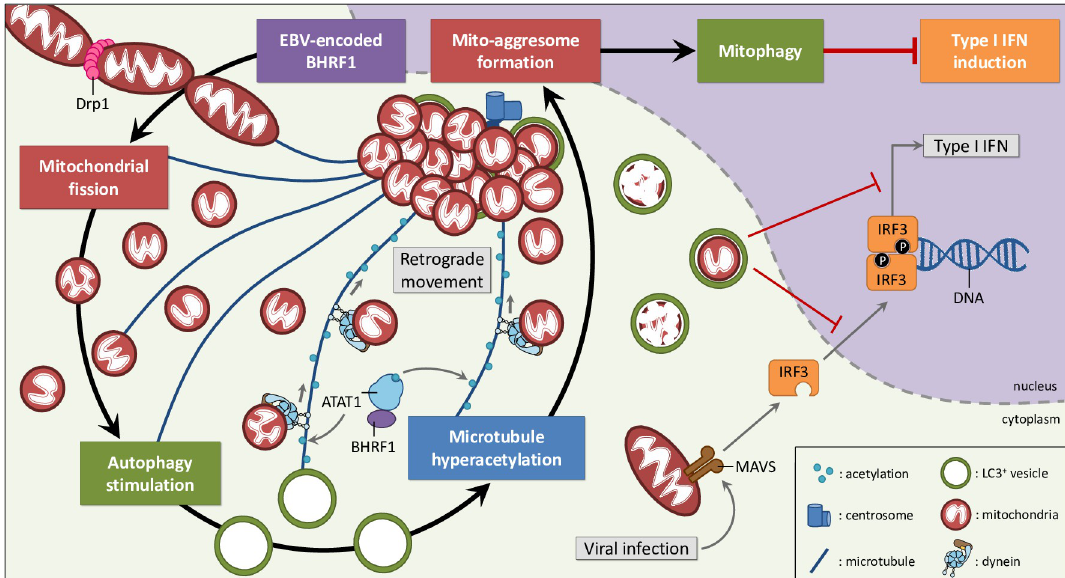
Fig 9. Working model. EBV encodes a Bcl-2 homolog that dampens type I IFN induction thanks to MT hyperacetylation. BHRF1 induces Drp1-mediated mitochondrial fission and subsequently autophagy. These cellular modifications lead to the mito-aggresome formation, and we demonstrated that the MT network and in particular its acetylation level are essential for this mitochondrial phenotype. Moreover, BHRF1 interacts with ATAT1 and induces MT hyperacetylation through ATAT1 activation. This hyperacetylation allows the retrograde transport of mitochondria in a dynein-dependent manner. Finally, sequestration and degradation of mitochondria block the innate immunity.